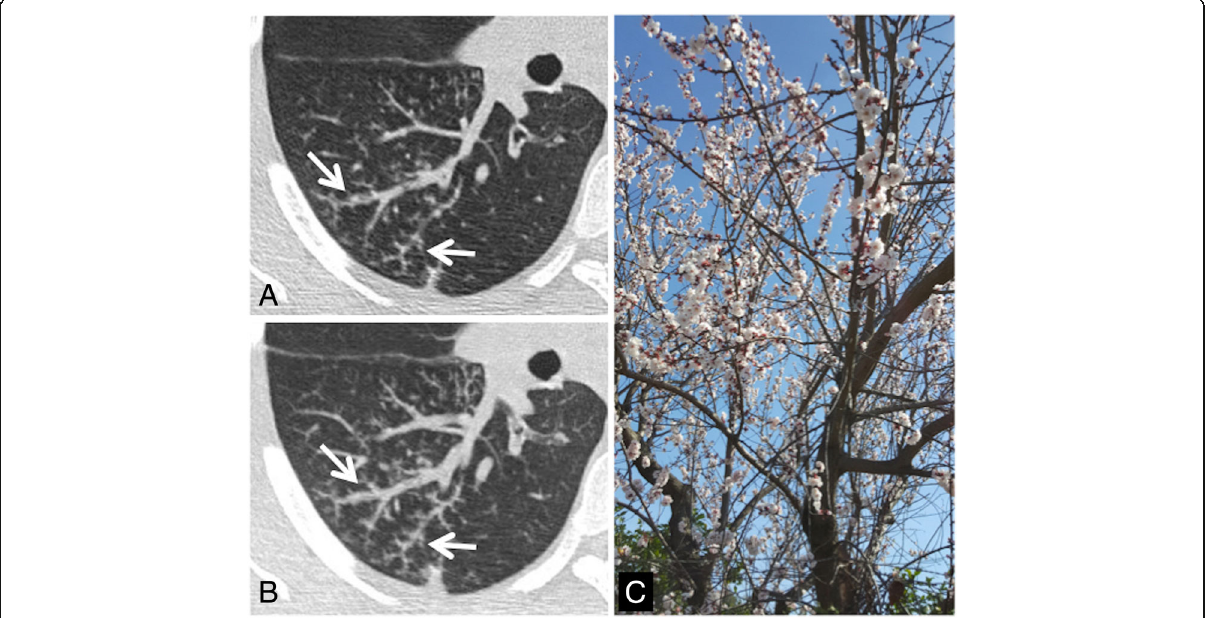
Fig. 33 Tree-in bud sign. Small centrilobular nodularities and linear ramifications (white arrows in a and b ) may be appreciated in the right lower lobe of a patient with cough and fever; these CT findings — which show the typical appearance of tree-in-bud — are related to the presence of inflammatory bronchiolitis. This tree-in-bud appearance is a morphological pattern that resembles a flowering tree ( c